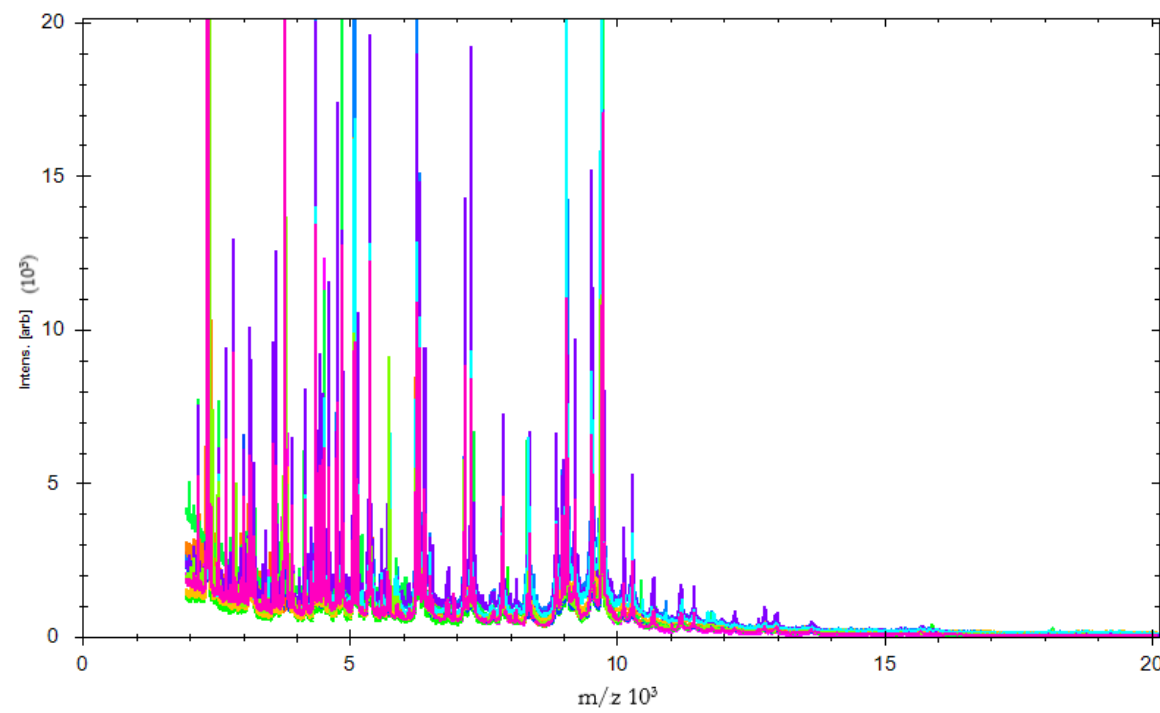
Figure 1. Characteristic spectra of MALDI-TOF MS. The variations in the mass spectrum of E. coli isolates are displayed by color.